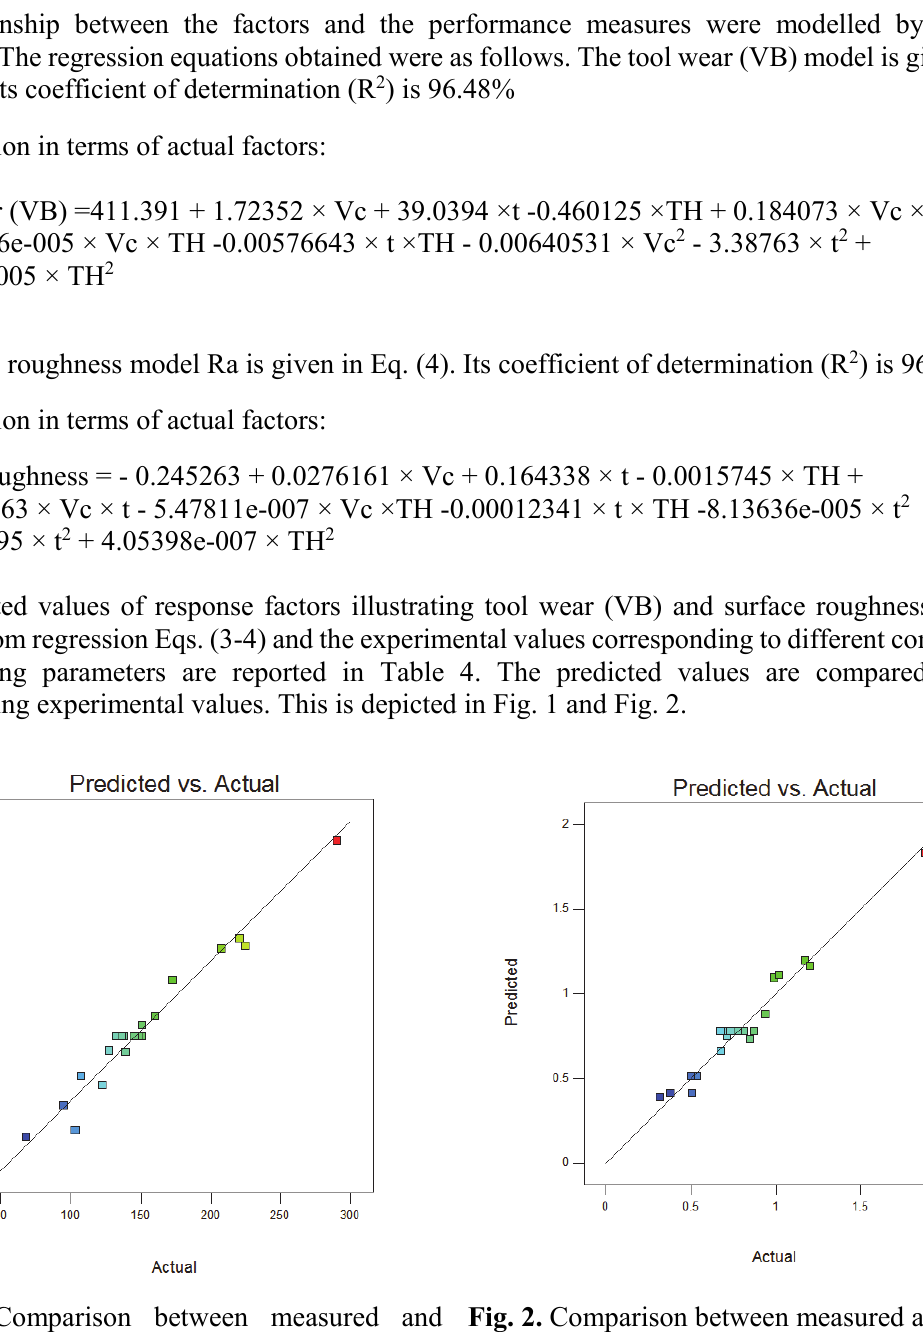
Fig. 2. Comparison between measured and predicted values for surface